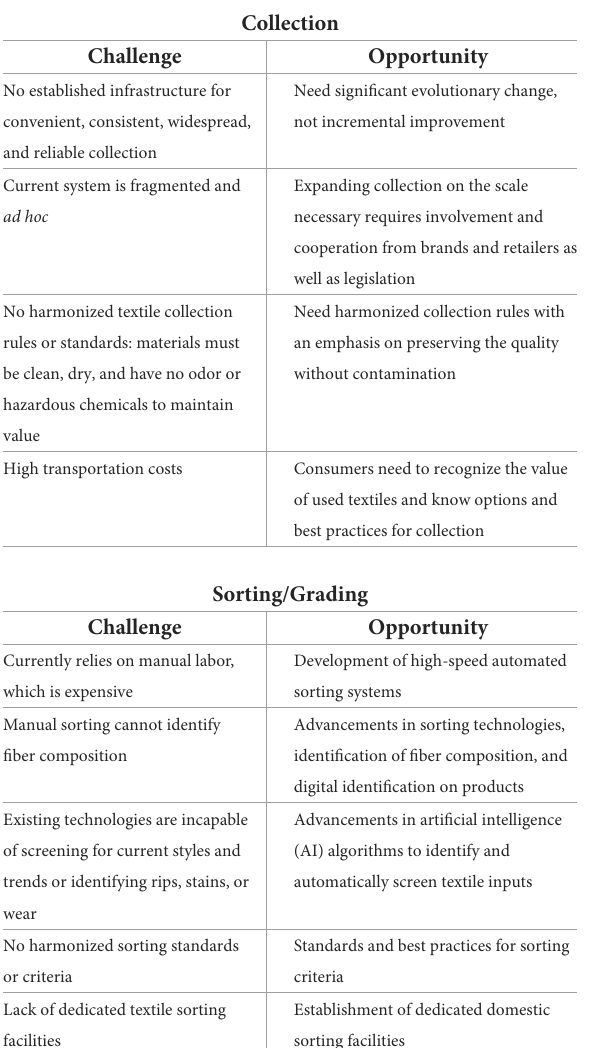
TABLE 1 Challenges and opportunities for textiles collection (Schumacher and Forster,